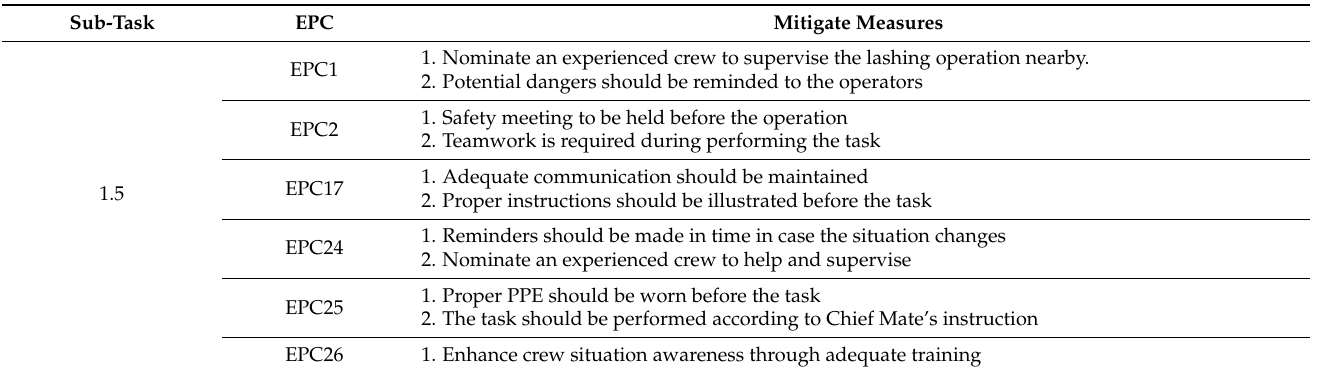
Table 8. Recommendations for HEP